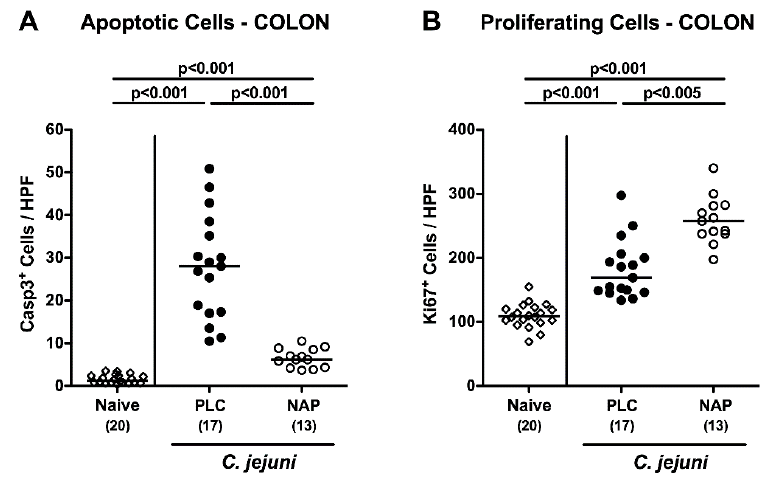
Figure 3. Colonic epithelial apoptotic and proliferative cell responses following NAP treatment of C. jejuni infected secondary abiotic IL10 − / − mice. On day (d) 0 and d1 secondary abiotic IL10 − / − mice